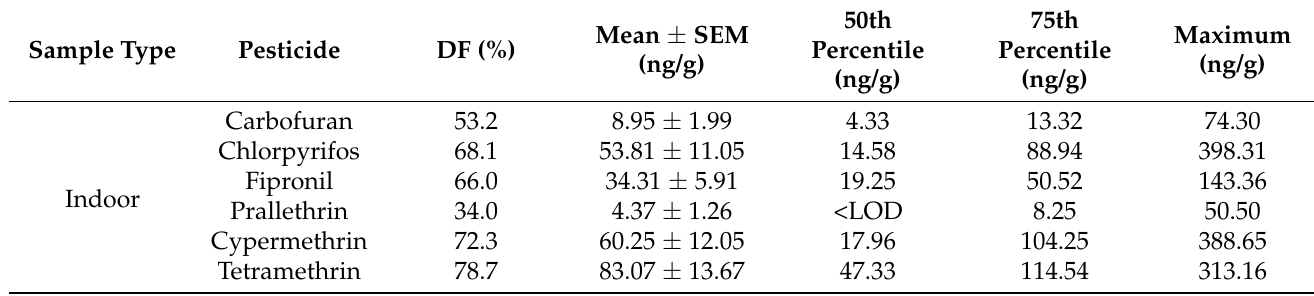
Table 1. Pesticide concentrations of indoor and outdoor dust ( n =